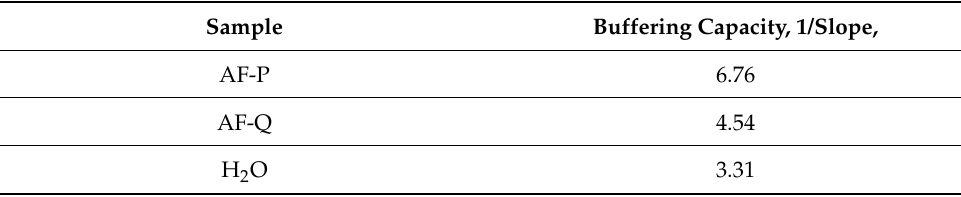
Table 2. Buffering capacity of PDMAEMA star-shaped polymers given as reciprocal value of the slope of curves from Figure 1b over a pH range from 10 to